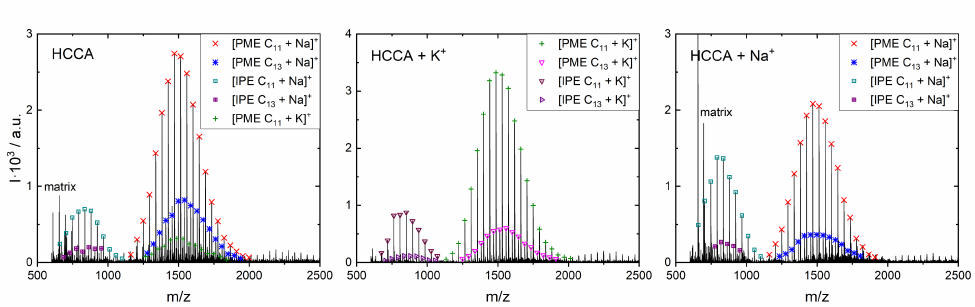
Figure A1. MALDI-TOF spectra of Tween20 from a pure HCCA matrix and from HCCA matrices upon addition of K + or Na + salt.